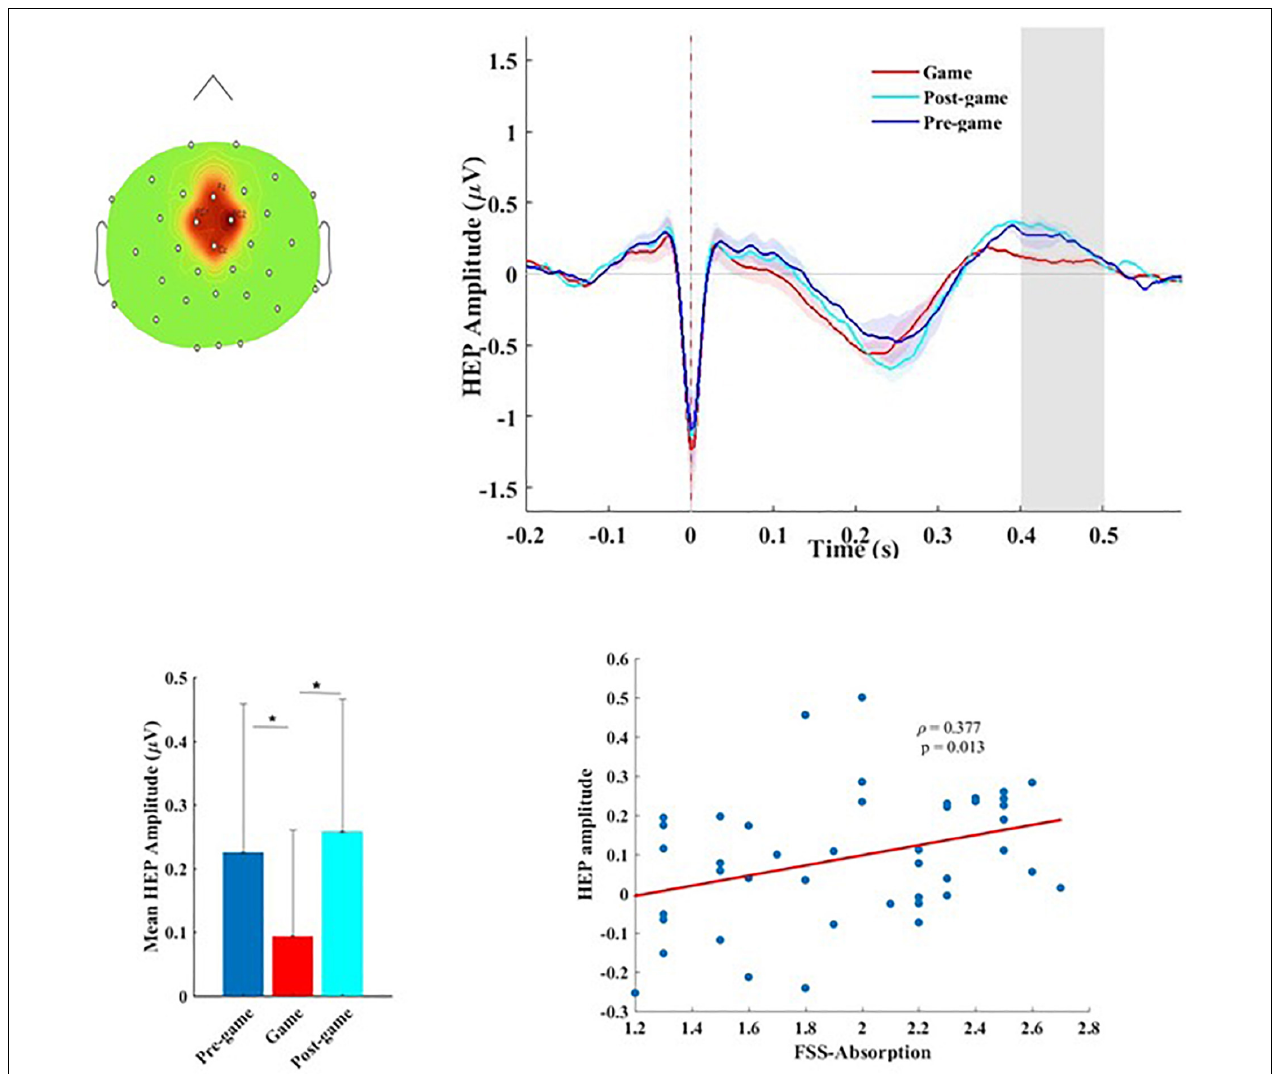
FIGURE 2 | (A) Topographical map of the scalp sensors where the distinct heart-evoked potential (HEP) between the game and the pre-/post-game conditions was observed. The red-colored region including FC1, FC2, Fz, and Cz sensors indicates the location of the electrodes contributing to this significant difference, (B) the grand average HEP across fronto-central sensors for the three conditions. The shaded area shows the time window in which we observed a significant difference. (C) Mean amplitude and the standard deviation of the HEP over the 400–500 ms time window in which the significant difference was observed for the three conditions, (D) Flow-absorption score as a function of the HEP